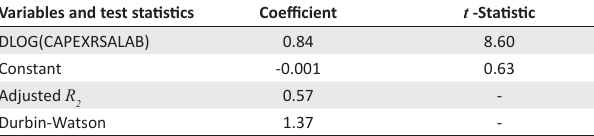
TABLE 1: Output of the regression equation. Variables and test